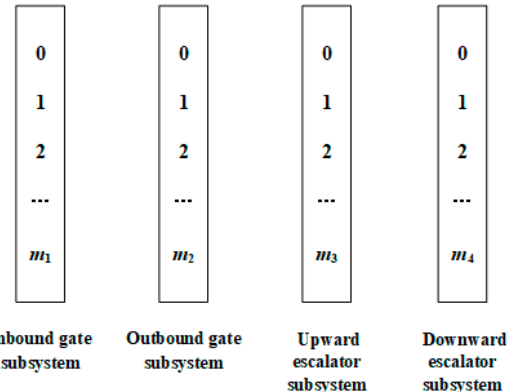
Figure 3. The number of key equipment working normally at the station.